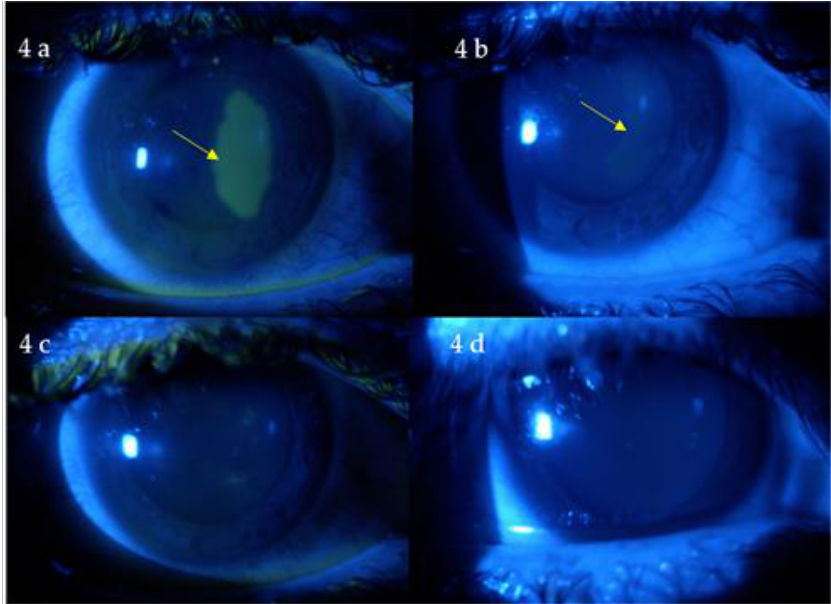
Figure 4. ( a ) Biomicroscopic appearance of the corneal surface at postoperative day 1; the yellow arrow shows a large area of corneal staining. ( b ) The same eye at postoperative control day 2; the yellow arrow shows a faint residual de-epithelialized area. ( c ) On postoperative control day 3, the cornea is completely re-epithelialized. ( d ) Postoperative control day 4 and removal of bandage contact lens. Table 3. A summary of the values of demarcation line depth and endothelial cell count in the 10 eyes treated with accel- erated corneal cross-linking using SafeCross ® solution. No eye presented signs of endothelial damage at the postoperative control day 30, also compared with the fellow untreated eye; cell count and morphology remained well in treated eyes was 2342 cells/mm 2 (range, 2042–2692 cells/mm 2 ) and 2456 cells/mm 2 in